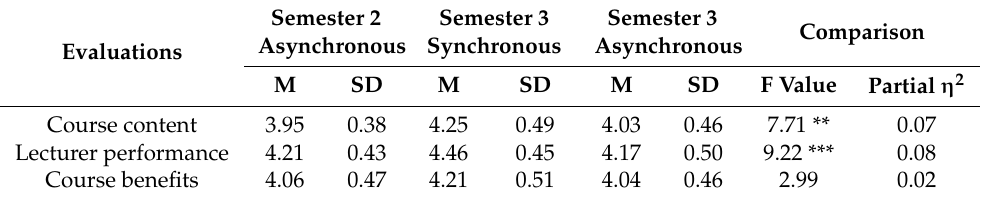
Table 5. Comparisons of subjective evaluation among three courses.